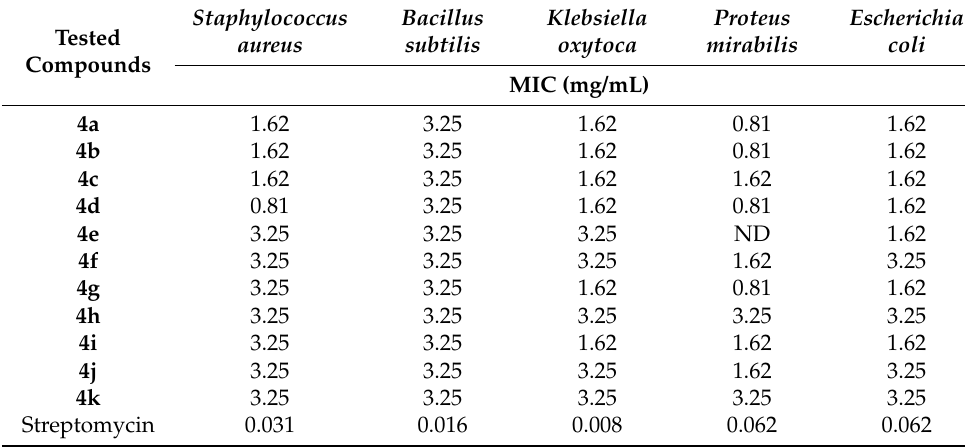
Table 3. The antibacterial activity of the tested compounds. Tested